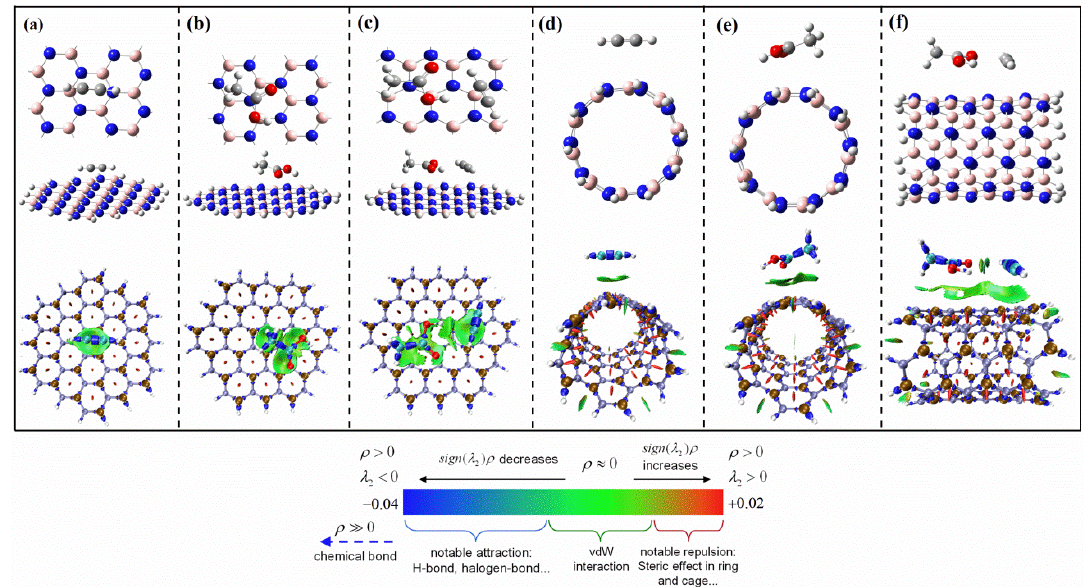
Figure 4. Optimized adsorption structures of C 2 H 2 and CH 3 COOH molecules on BN nanomaterials and the corresponding interaction region indicator (IRI) analysis (( a – c ) are the single adsorption and co-adsorption structures of C 2 H 2 and CH 3 COOH molecules on BNNS, respectively; ( d – f ) are the single adsorption and co-adsorption structures of C 2 H 2 and CH 3 COOH molecules on BNNT, respectively).